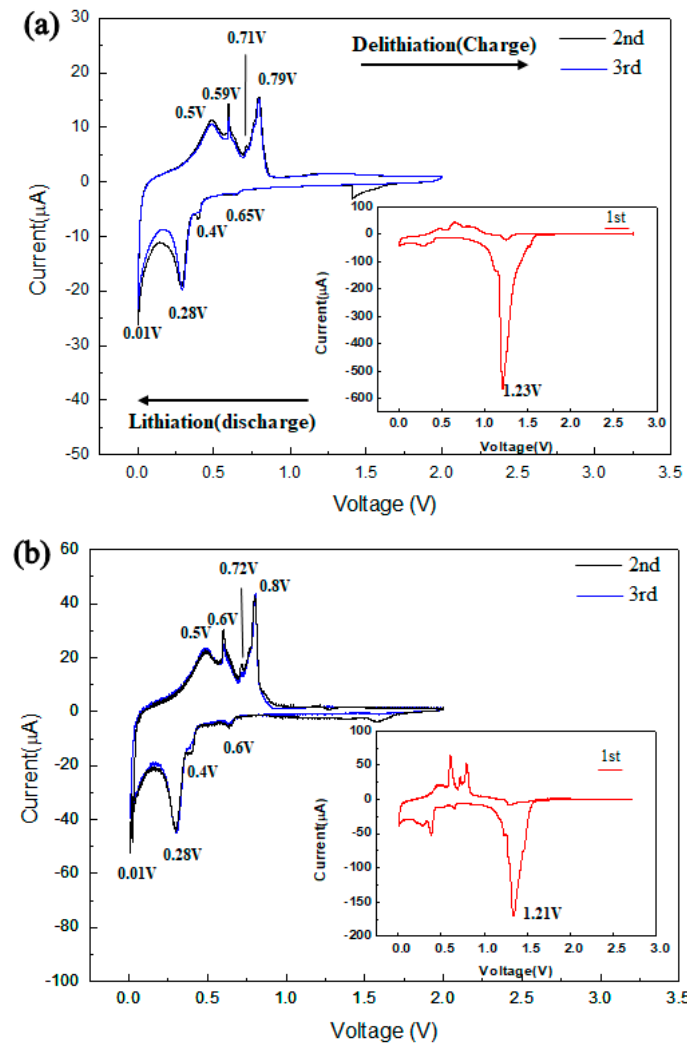
Figure 5. Cyclic voltammetry results for the ( a ) Sn and ( b ) Sn/TiNi electrode in the second and third cycles at 0.1 mV/s in the voltage window of 0.01~2.0 V (vs. Li + /Li). Insets show the results of the first cycle.